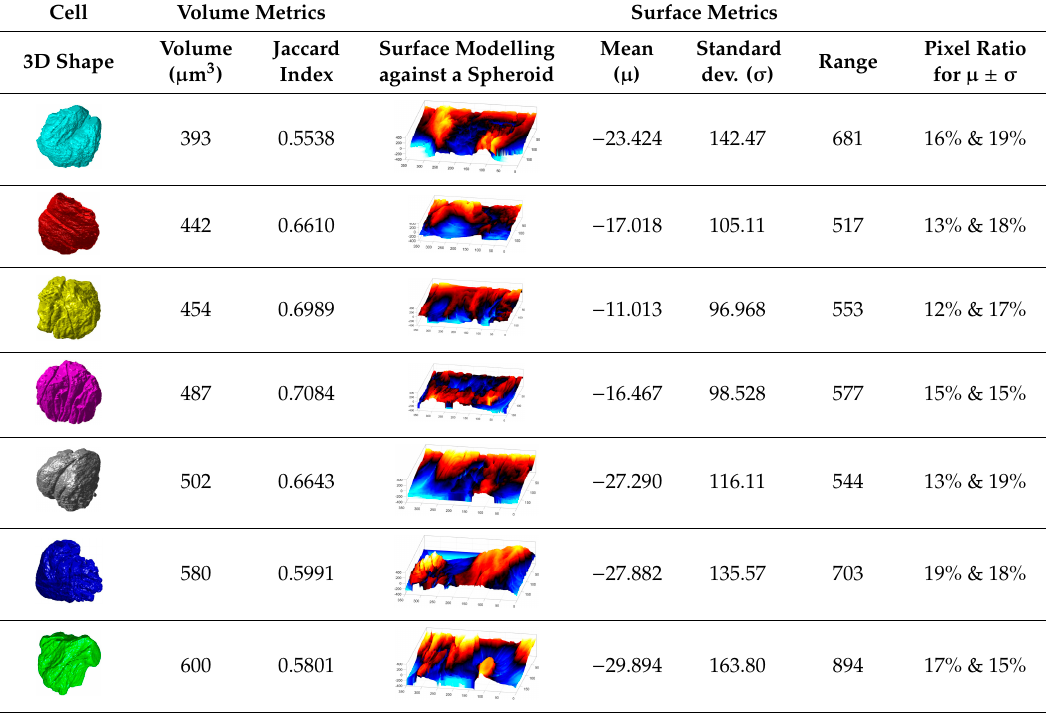
Table 1. Quantitative metrics extracted from surface modelling. Examples of metrics that can be automatically extracted from the nuclear envelope (NE) segmentation, including nuclear volume and Jaccard Index (JI) against the spheroid, and the mean value ( μ ), standard deviation ( σ ), range of values for the NE (distance of the highest peaks and deepest valleys from the spheroid). The last column shows the ratio of the number of pixels to the total number of pixels in one standard deviation above and below the mean value, as height/depth of a peak/valley may not indicate if this is a thin spike or more of a plateau. In addition to a strong negative correlation between JI and σ , with correlation coefficient ( − 0.9139) which explains the similarity between the NE and the spheroid, and a weaker negative correlation between JI and range, with correlation coefficient ( − 0.7388), a comparatively weaker positive correlation between JI and μ with correlation coefficient (0.7142) was observed. These values could be used to draw some conclusions about biological characteristics of cells and more metrics can be extracted from the algorithm developed for this work.